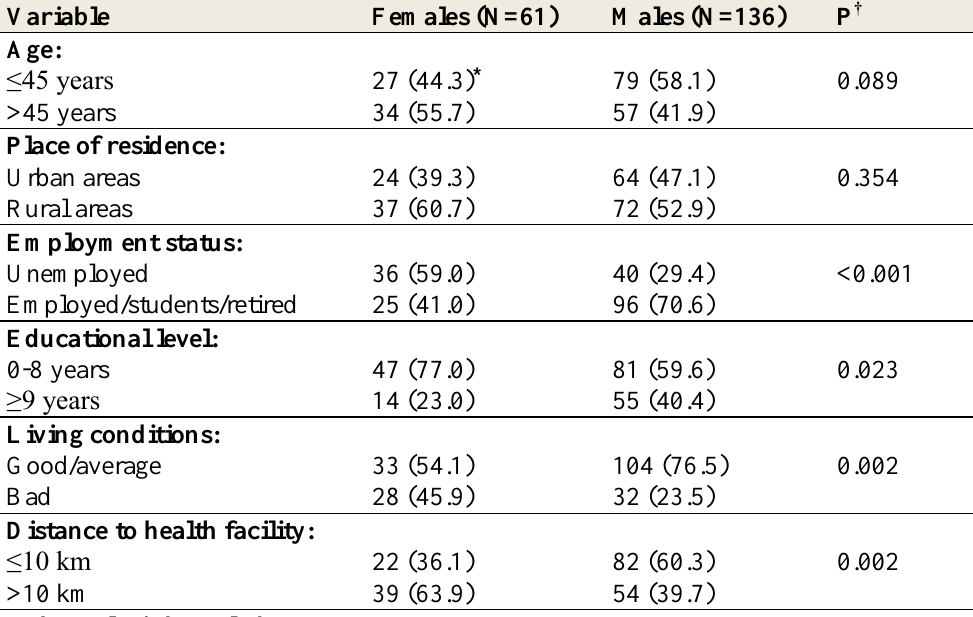
Table 1. Distribution of socioeconomic characteristics, knowledge and attitudes about tuberculosis, and access to health care among tuberculosis patients in Albania by sex